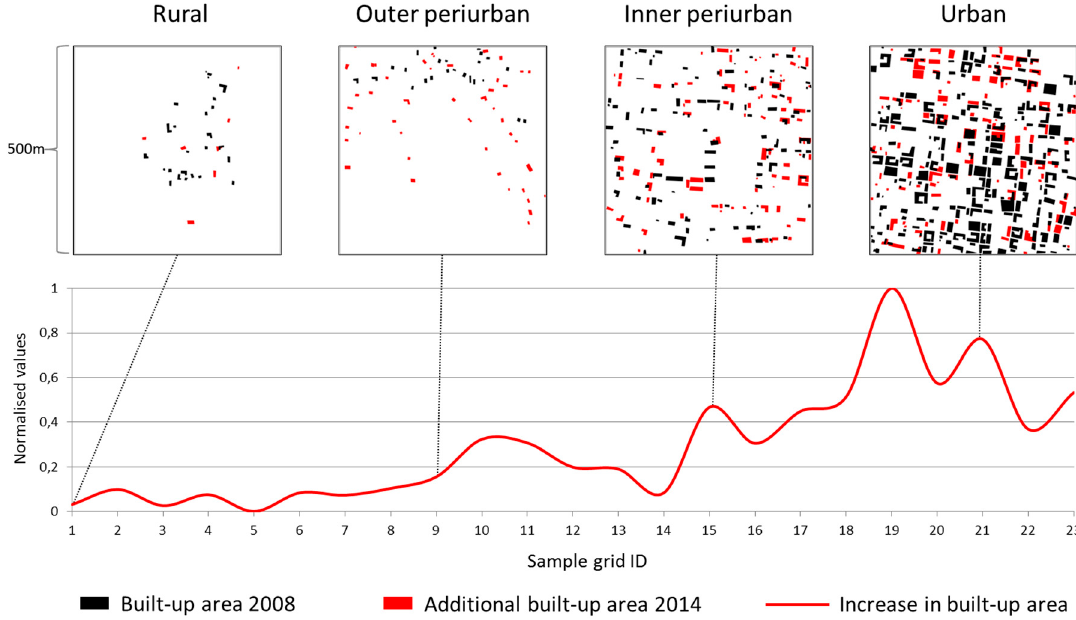
Figure 7. Absolute changes in built-up area between 2008 and 2014 exemplified by four sample grid cells representing the four categories (sorted according to urbanicity values).